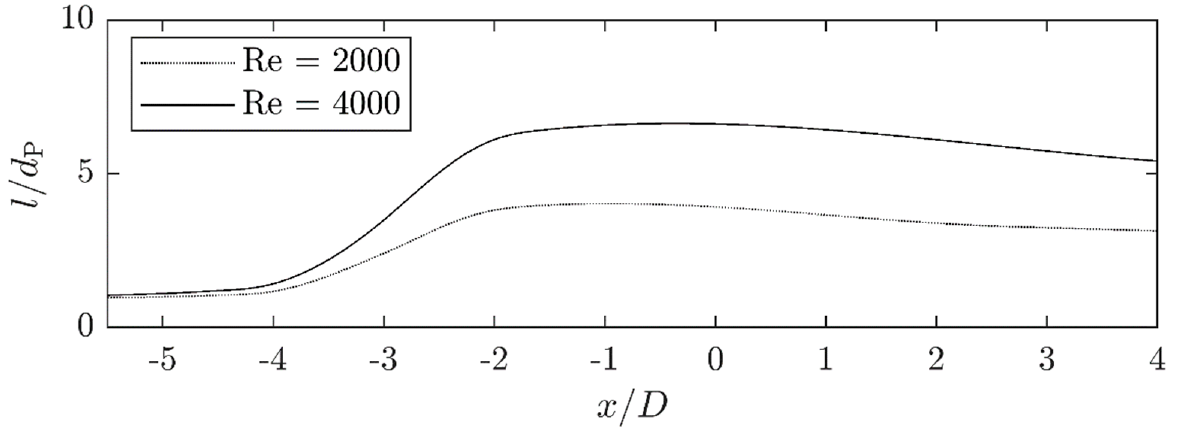
Figure 13. Comparison of the aspect ratio of two drops with the viscosity ratio of λ = 10.8 stressed at different Reynolds numbers. The curves show the elongation ratio recorded by the two individual cameras, whereby the elongation ratio is shown over the observed position of the center of the droplet. This point may already be located in zones of higher or lower elongation rates, while the drop front or end is located in other zones and thus exposed to different elongation